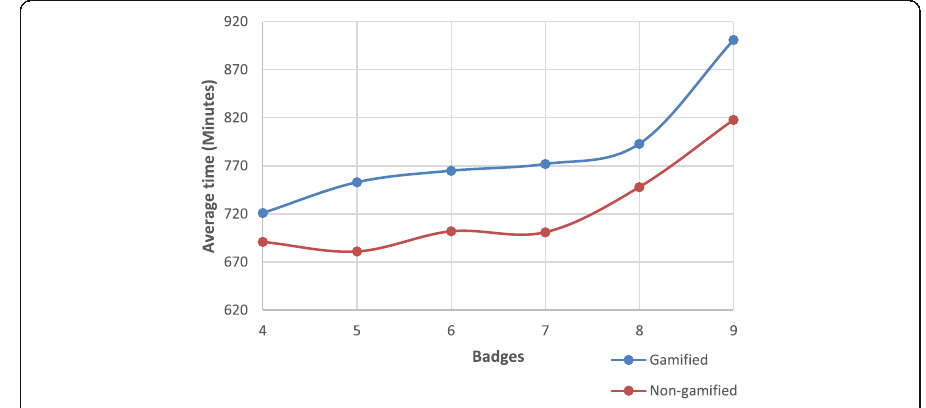
Fig. 3 Gamified versus non-gamified